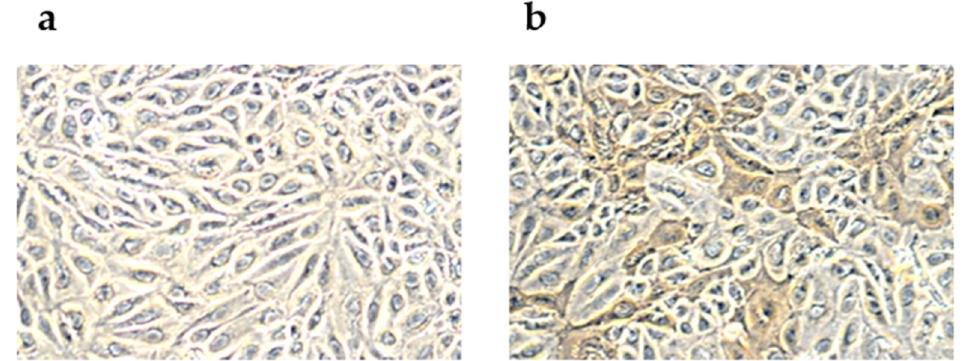
Figure 1. Immunoperoxidase staining of Madin–Darby canine kidney (MDCK) cells infected with equine influenza virus (MOI of 10), ( a ) Mock-infected MDCK cells; ( b ) MDCK infected with A/equi/Kentucky 81 cells.